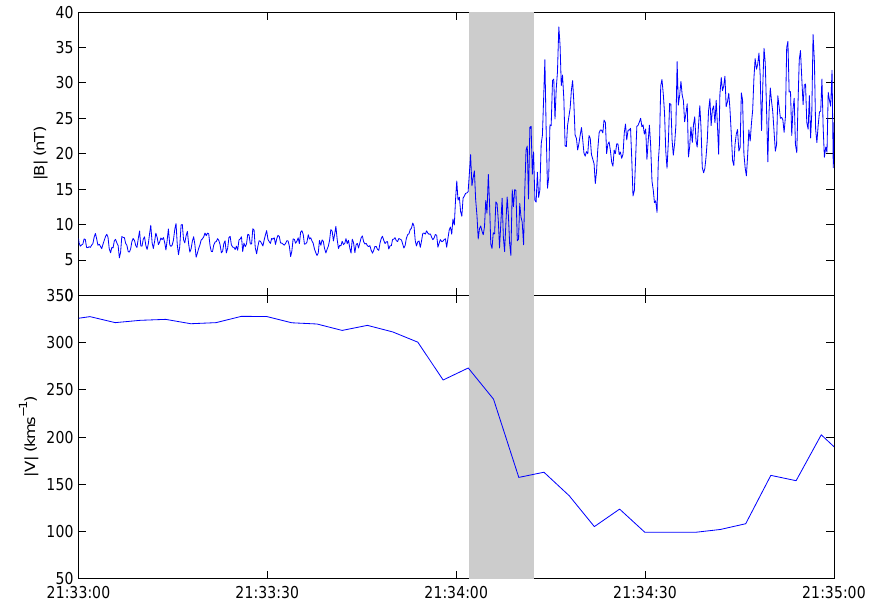
Fig. 1. The magnitude of the magnetic field (top) and the flow velocity (bottom) measured during the shock crossing on 26 February